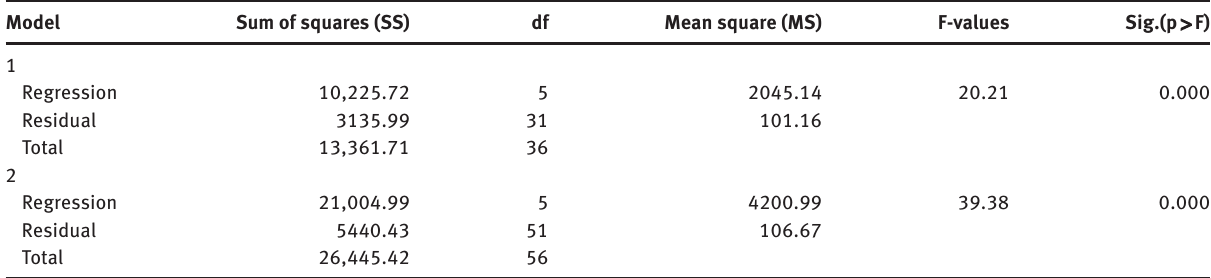
Table 7: ANOVA statistics.